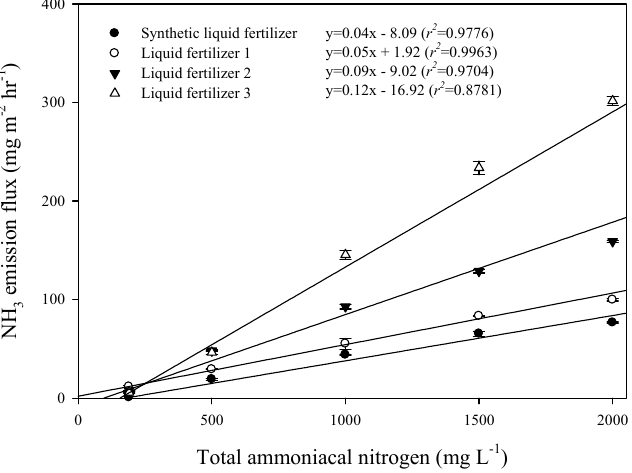
Figure 2. Changes in ammonia emission flux by liquid fertilizer type using a dynamic chamber-capture system at 20 ° C and pH 8 condition. Error bar means standard deviation (SD, n = 3).